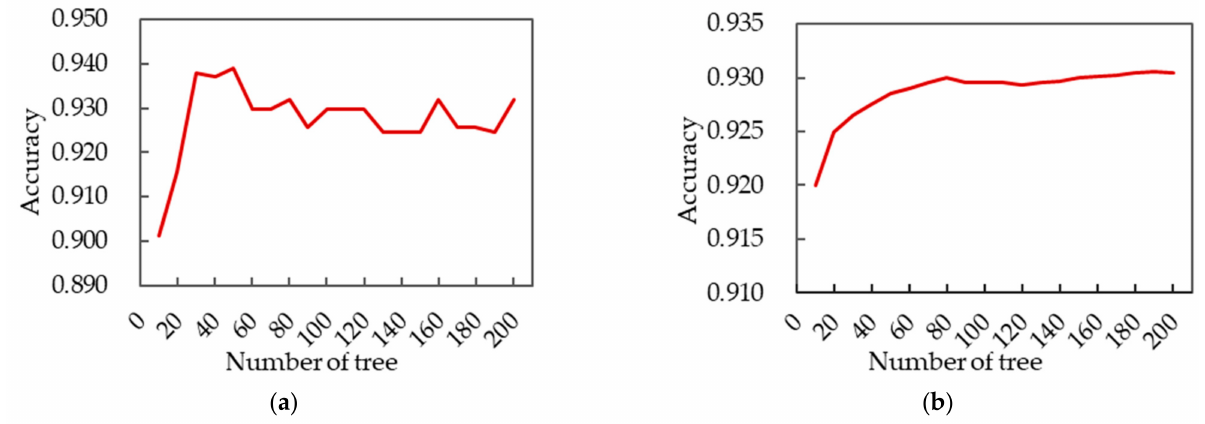
Figure 5. The convergence of the accuracy of ( a ) Model 1 and ( b ) Model 2. The models were trained with an increasing number of decision trees, and the accuracy of classification was evaluated from the field-based (Model 1) and pixel-based (Model 2) classification,